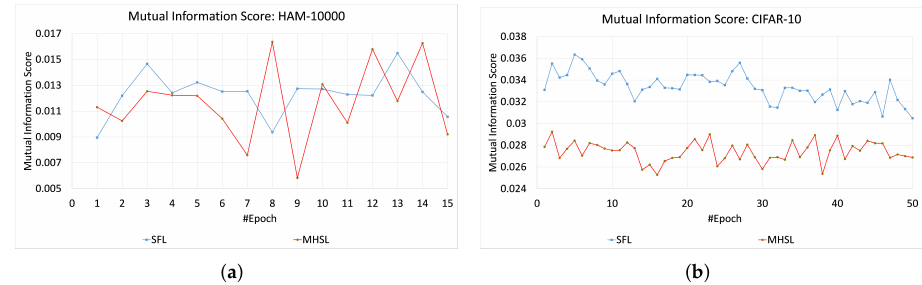
Figure 4. Mutual information score across the epochs for SFL and MHSL for three-channel datasets ( a ) HAM-10000 and ( b )